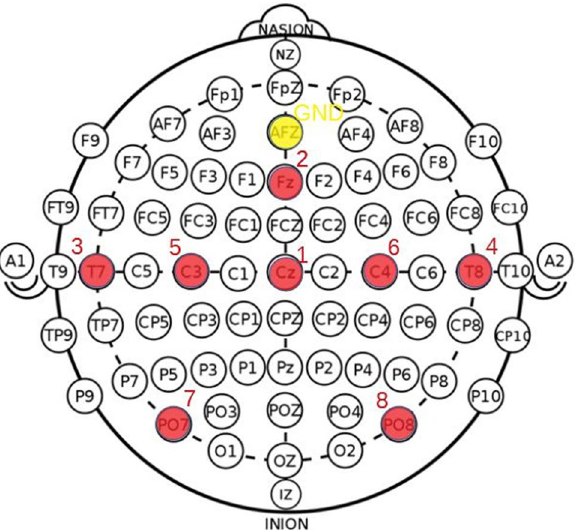
Figure 2. The positions of the EEG electrodes are shown by red circles. These electrodes cover the frontal lobe (by Fz), central lobe (by C3, C4, and Cz), temporal lobe (by T7 and T8), and parietal lobe (by PO7 and PO8). Two EOG electrodes (not shown here) were also placed in the lower and upper areas of the right eye to record eye movements. The ground electrode was placed in the AFZ position, marked by a yellow circle.